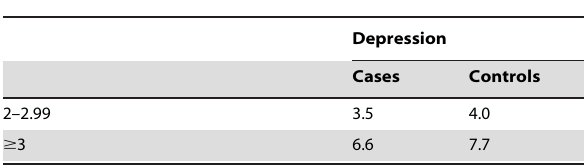
Table 1. Baseline population characteristics of the NIH-AARP Diet and Health Study,